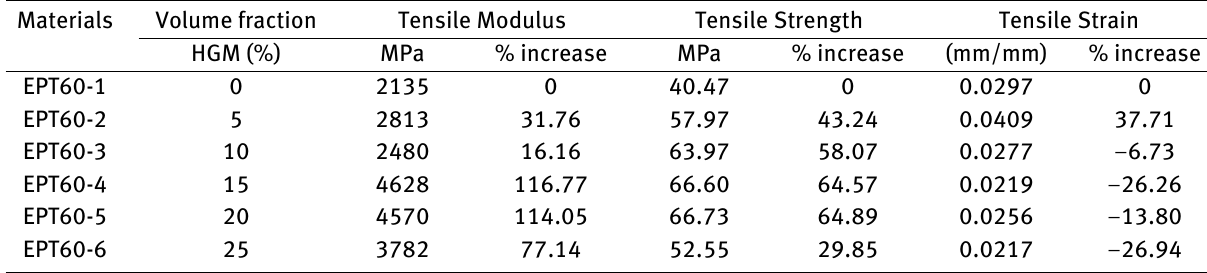
Table 3: Tensile strength of syntactic foam